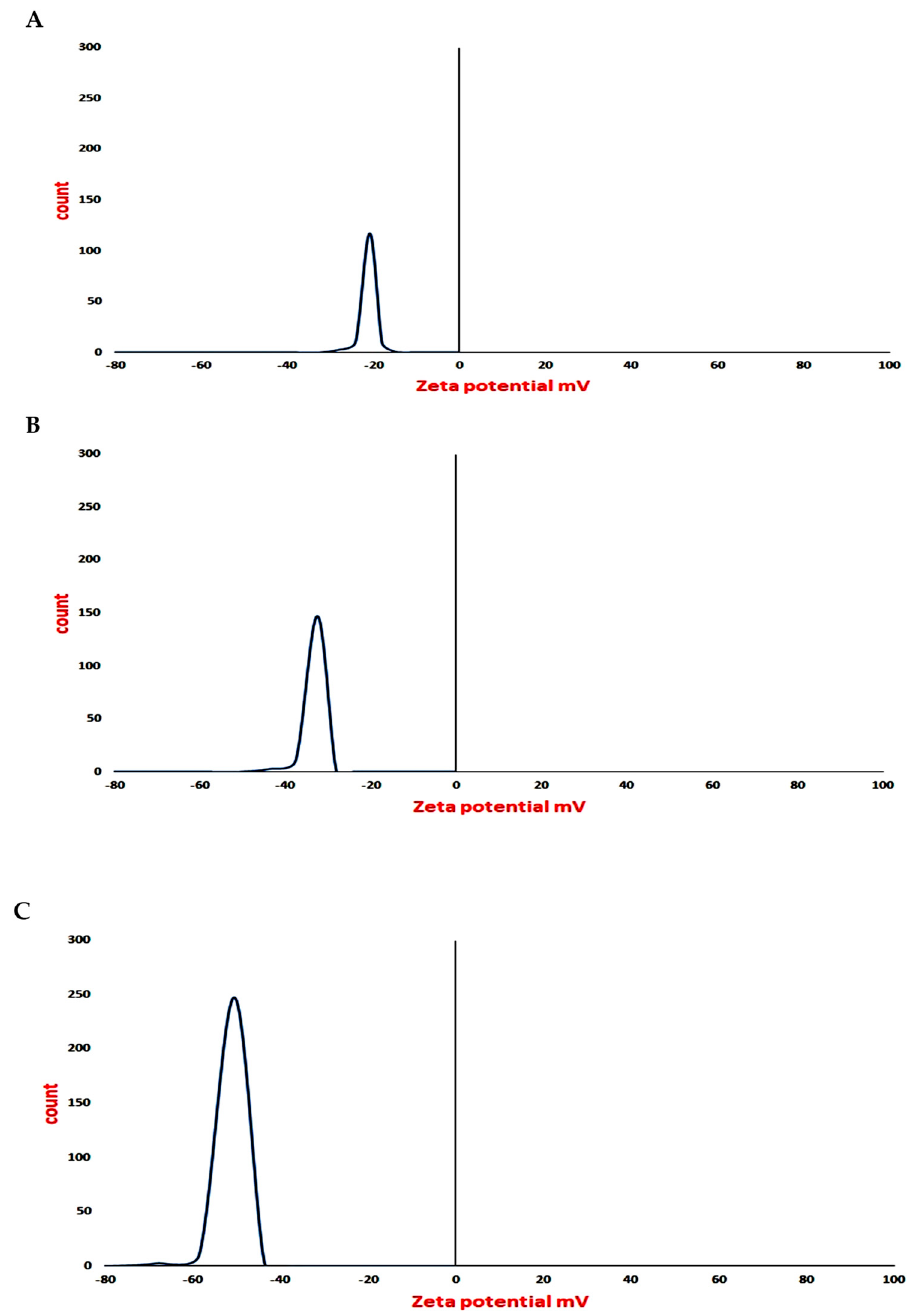
Figure 4. Zeta potential value for ( A ) silver nanoparticles (AgNPs), ( B ) silver mung bean protein nanocomposite (Ag-MNP), and ( C ) silver fenugreek protein nanocomposite (Ag- FNP).